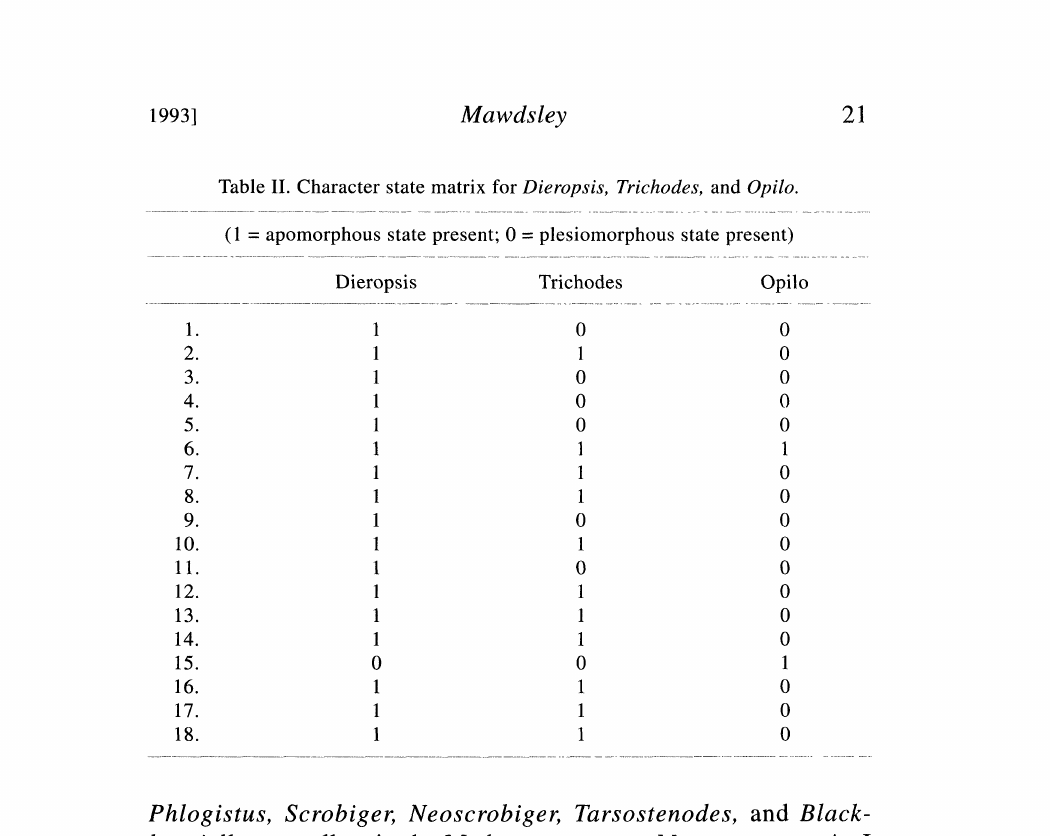
Table II. Character state matrix for Dieropsis, Trichodes, and Opilo. (1 apomorphous state present; 0 plesiomorphous state present) Dieropsis Trichodes